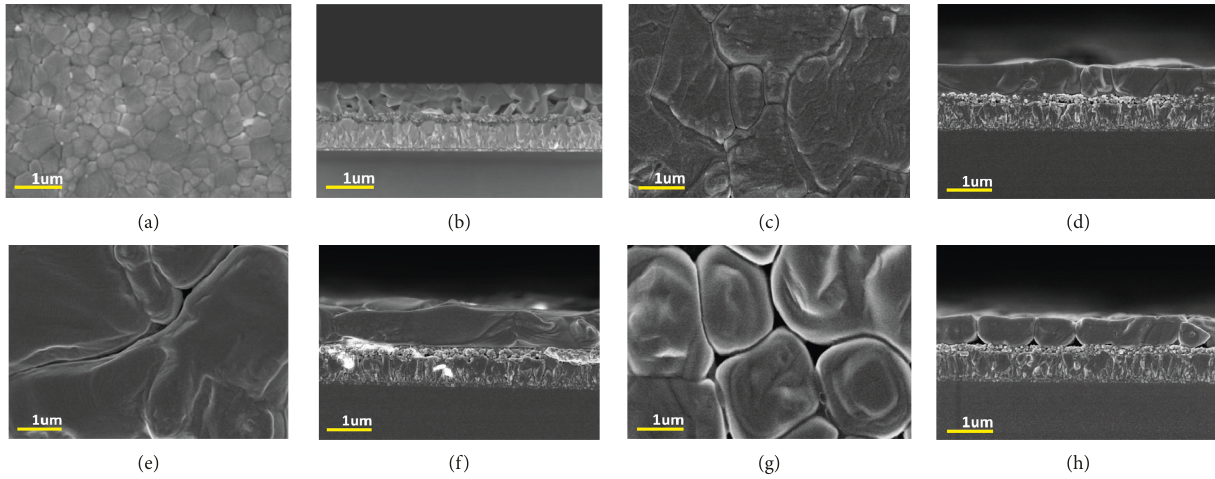
Figure 1: Top view and cross-sectional view of the SEM images for Sample+0 M (a, b), Sample+0.75M (c, d), Sample+0.9M (e, f), and Sample+1.2M (g,